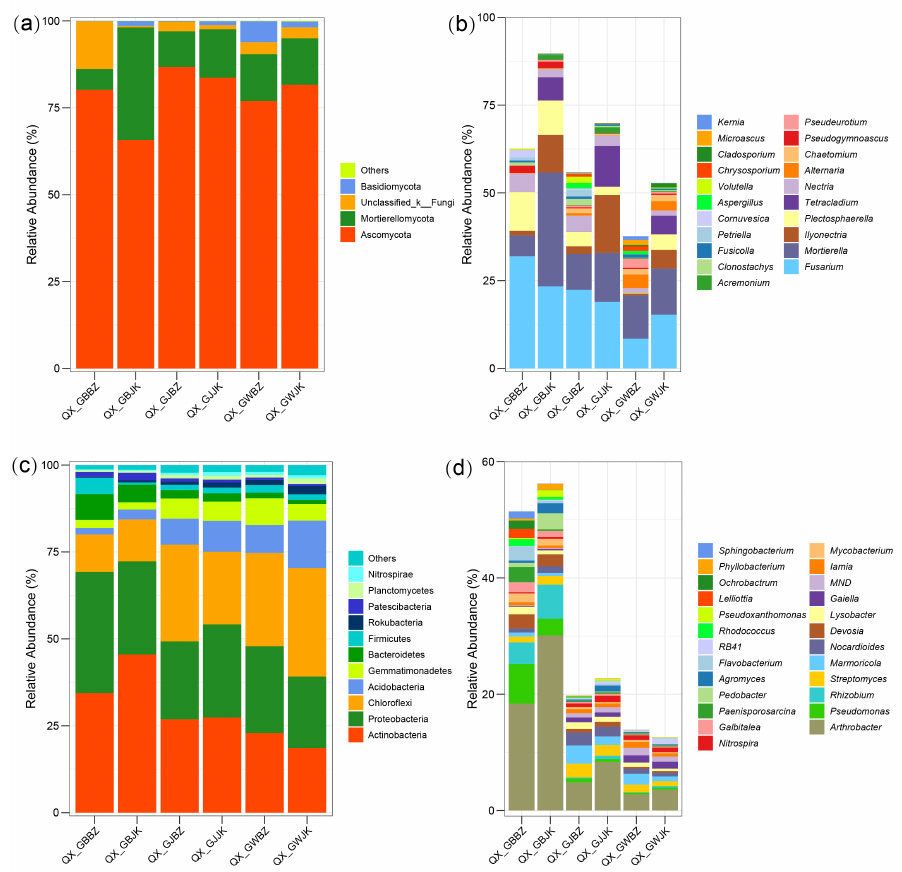
Figure 5. Relative abundance of fungal and bacterial communities at the phylum and genus levels. Note: ( a ) denotes the phyla of fungi, ( b ) denotes the genera of fungi, ( c ) denotes the phyla of bacteria, and ( d ) denotes the genera of bacteria. QX_GBBZ denotes the rhizoplane diseased plants, QX_GBJK denotes the rhizoplane healthy plants, QX_GJBZ denotes the rhizosphere diseased plants, QX_GJJK denotes the rhizosphere healthy plants, QX_GWBZ denotes the root zone diseased plants, and QX_GWJK denotes the root zone healthy plants.